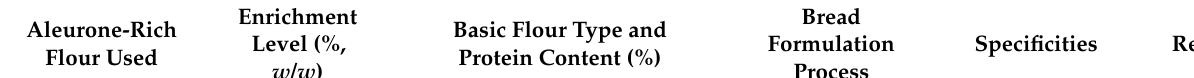
Table 8. Overview of existing aleurone-enriched bread formulation processes in